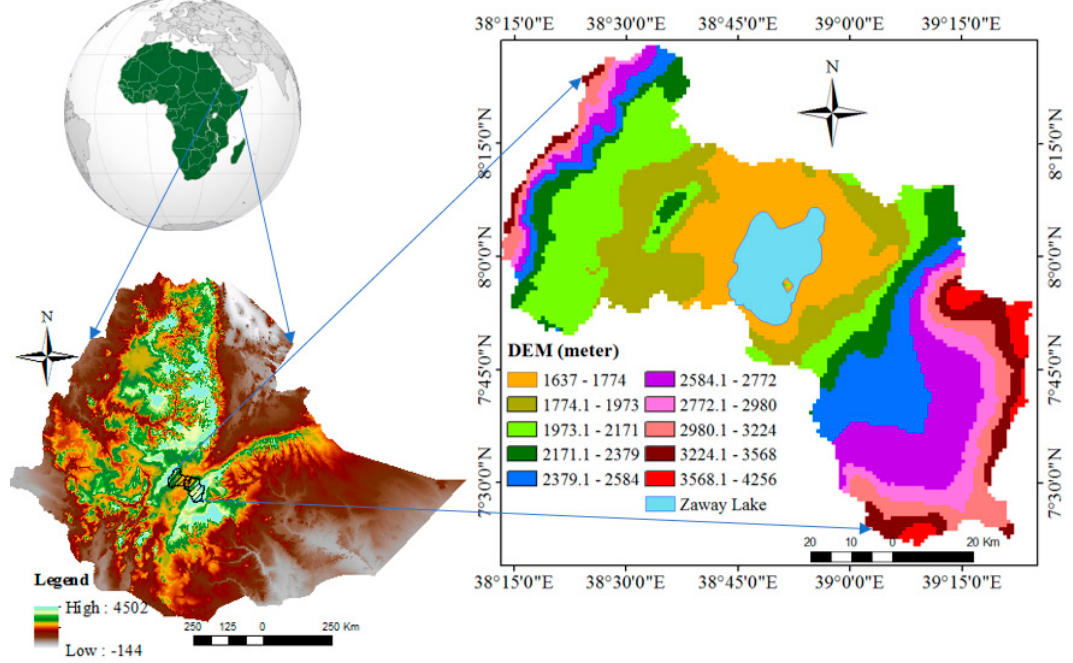
Figure 1. Location of the Lake Ziway basin in the Ethiopian Rift Valley.